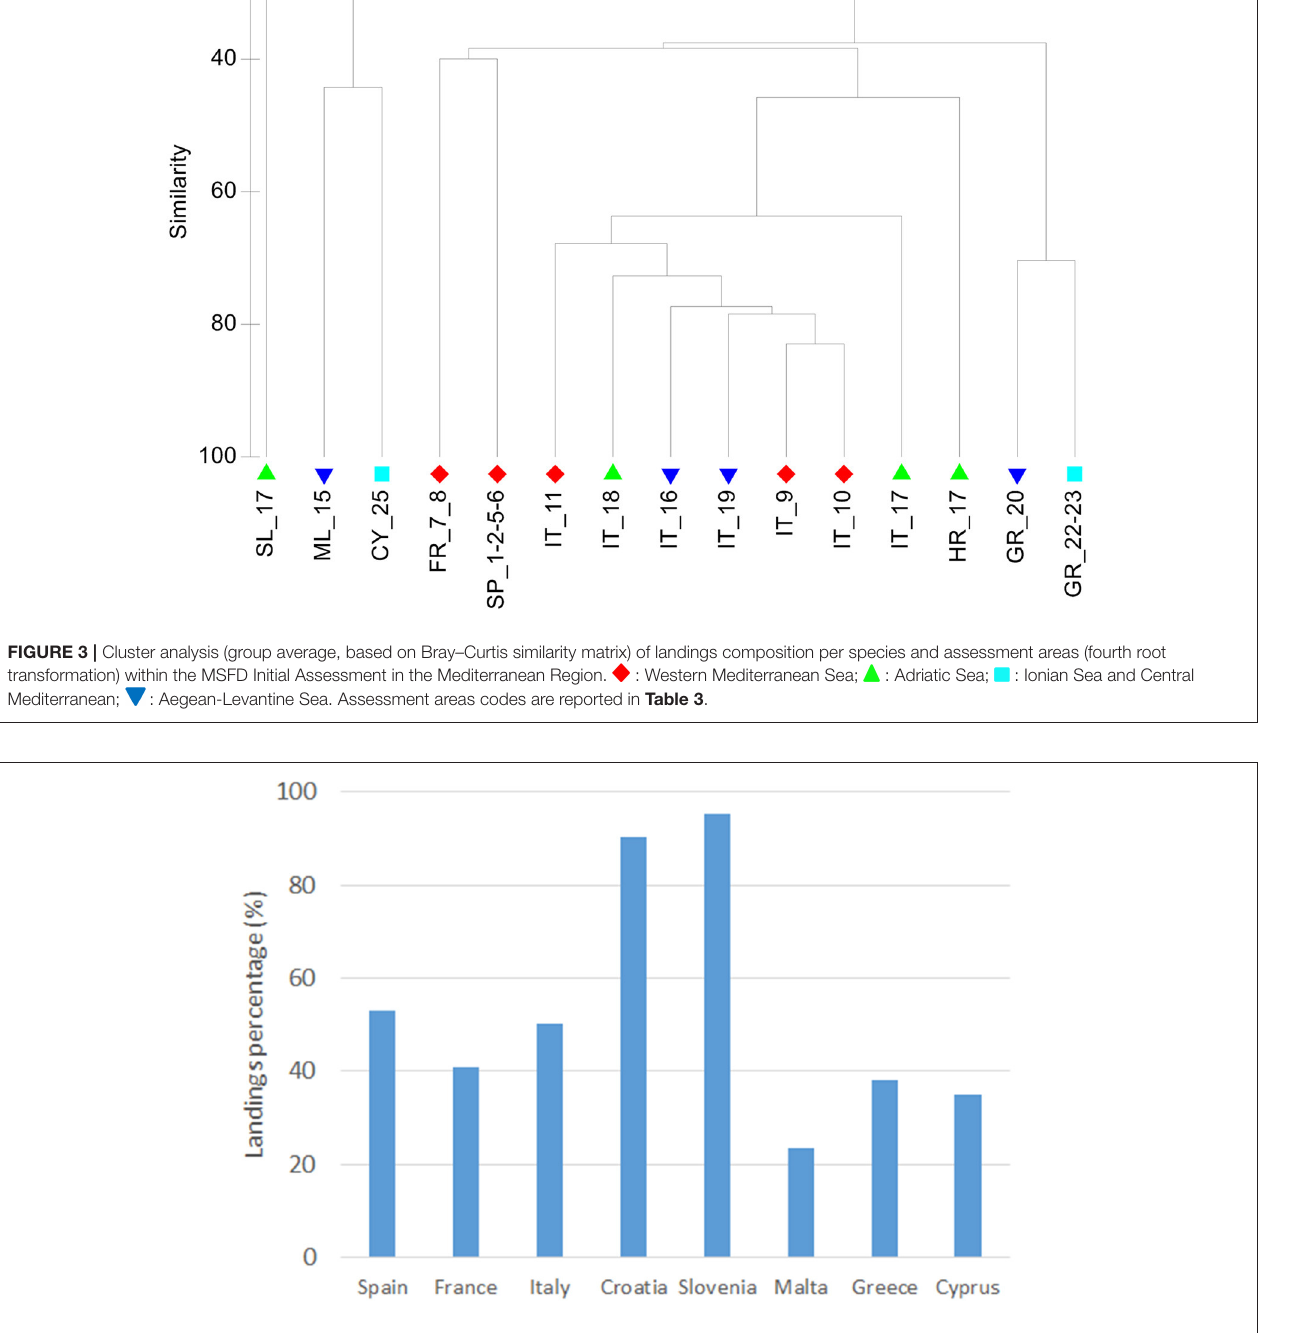
monitored under the DCF (EU, 2008) were higher than those considered for the IA ( Figure 5 ). Even the landings associated with species for which MLS was established according to EU